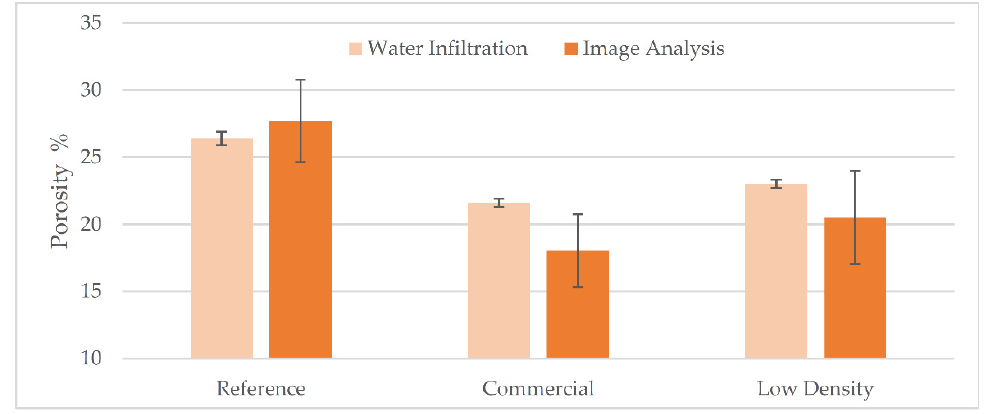
Figure 5. Comparison of porosity measurements performed by water infiltration and image analysis.